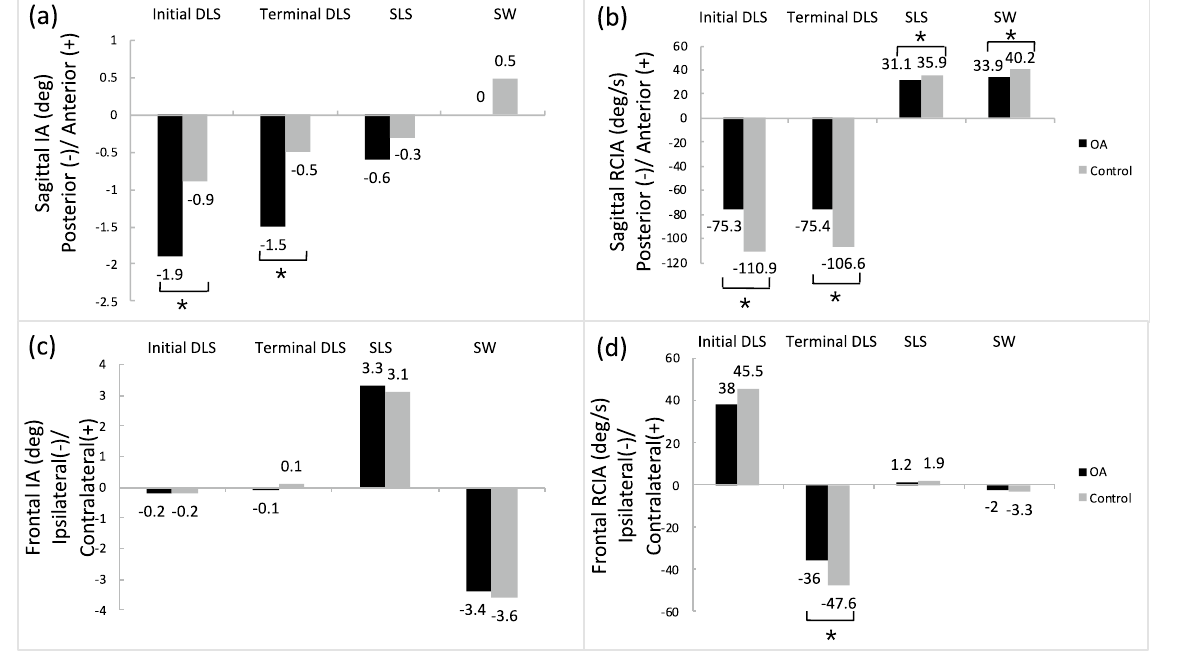
Figure 3. Mean values of time-averaged COM–COP inclination angles (IA) and their rates of change (RCIA) over phases of initial and terminal double-limb support (DLS), single-limb support (SLS) and swing during level walking in the sagittal ( a , b ) and frontal ( c , d ) planes for the knee osteoarthritis group and the control group. Positive sagittal and frontal IA indicate COM positions that are anterior and contralateral to the COP, respectively. Positive sagittal and frontal RCIA indicate rates of anterior changes and contralateral changes in the corresponding IA, respectively. Sagittal IA